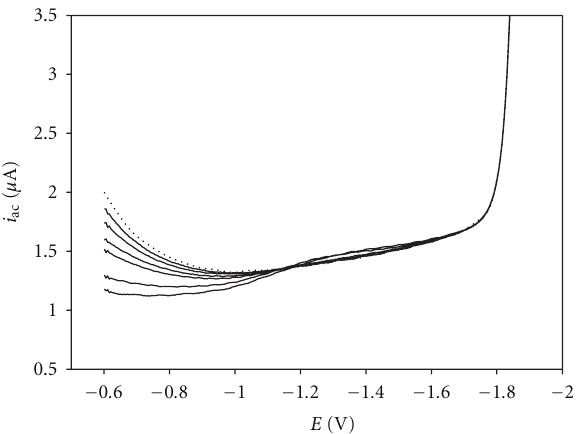
Figure 6: i ac (relative)- t curve constructed from the results in Figure 5. i ac current was recorded at − 0.6 V. The slope was calculated from the first 5 points on the